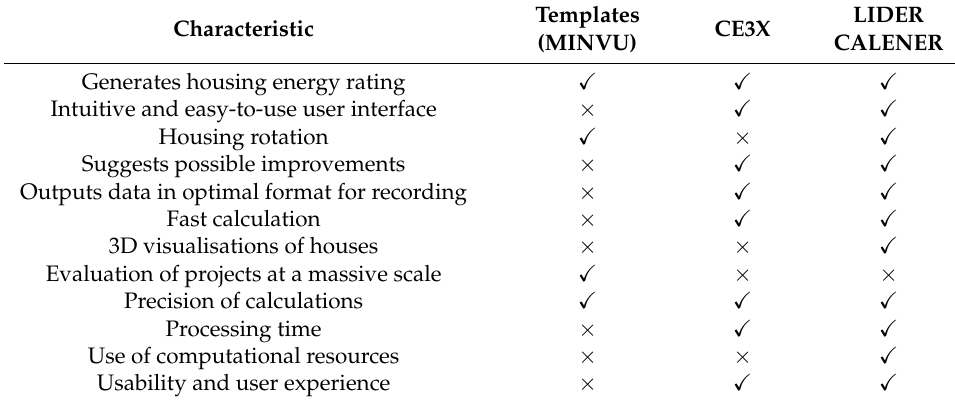
Table 1. Comparison table of the housing energy rating systems. Characteristic